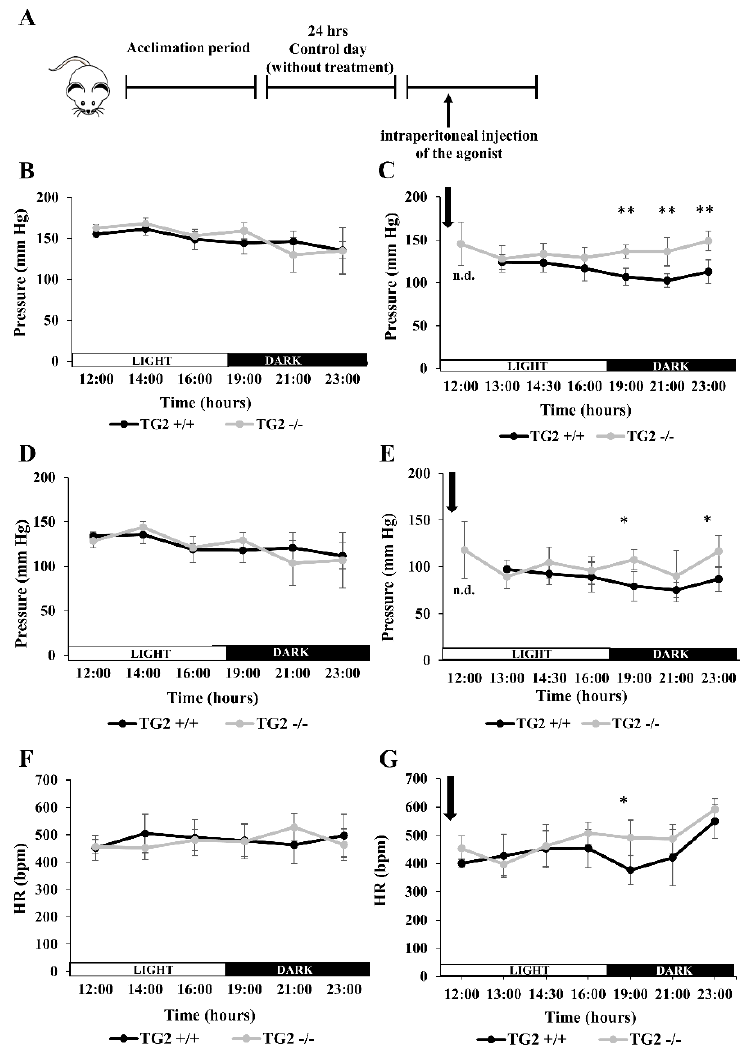
Figure 4. Phenylephrine treatment does not decrease tail blood pressure of TG2 -/- mice in contrast to TG2 +/+ . ( A ) Schematic presentation of the experiments. Tail blood pressure (TBP) and heart rate (HR) were measured at the same time points of both the acclimation day and the control day. On the third measurement day, mice were injected intraperitoneally with 60 nM/g body weight phenylephrine at 11:30 a.m. Systolic pressure on the control day ( B ) and the measurement day ( C ); and diastolic pressure on the control day ( D ) and on the measurement day ( E ) are presented separately. ( F ) HR values on the control day ( G ) HR values on the measurement day. Day (□) and night ( ■ ) periods are shown on the “X” axes. Arrowheads indicate the time point of phenylephrine injection. Measurement points represent the mean values ± SD. Statistical analyses were carried out using Student’s t -test ( n = 5, * p < 0.05, ** p < 0.01).